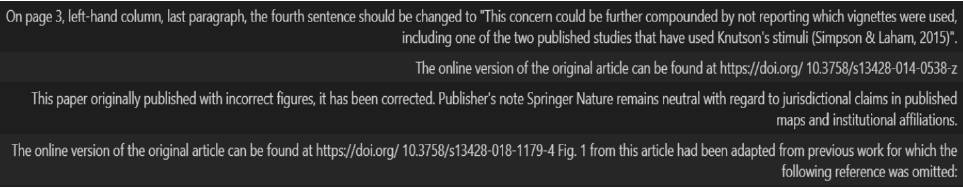
Figure 2. Examples of short publications that were